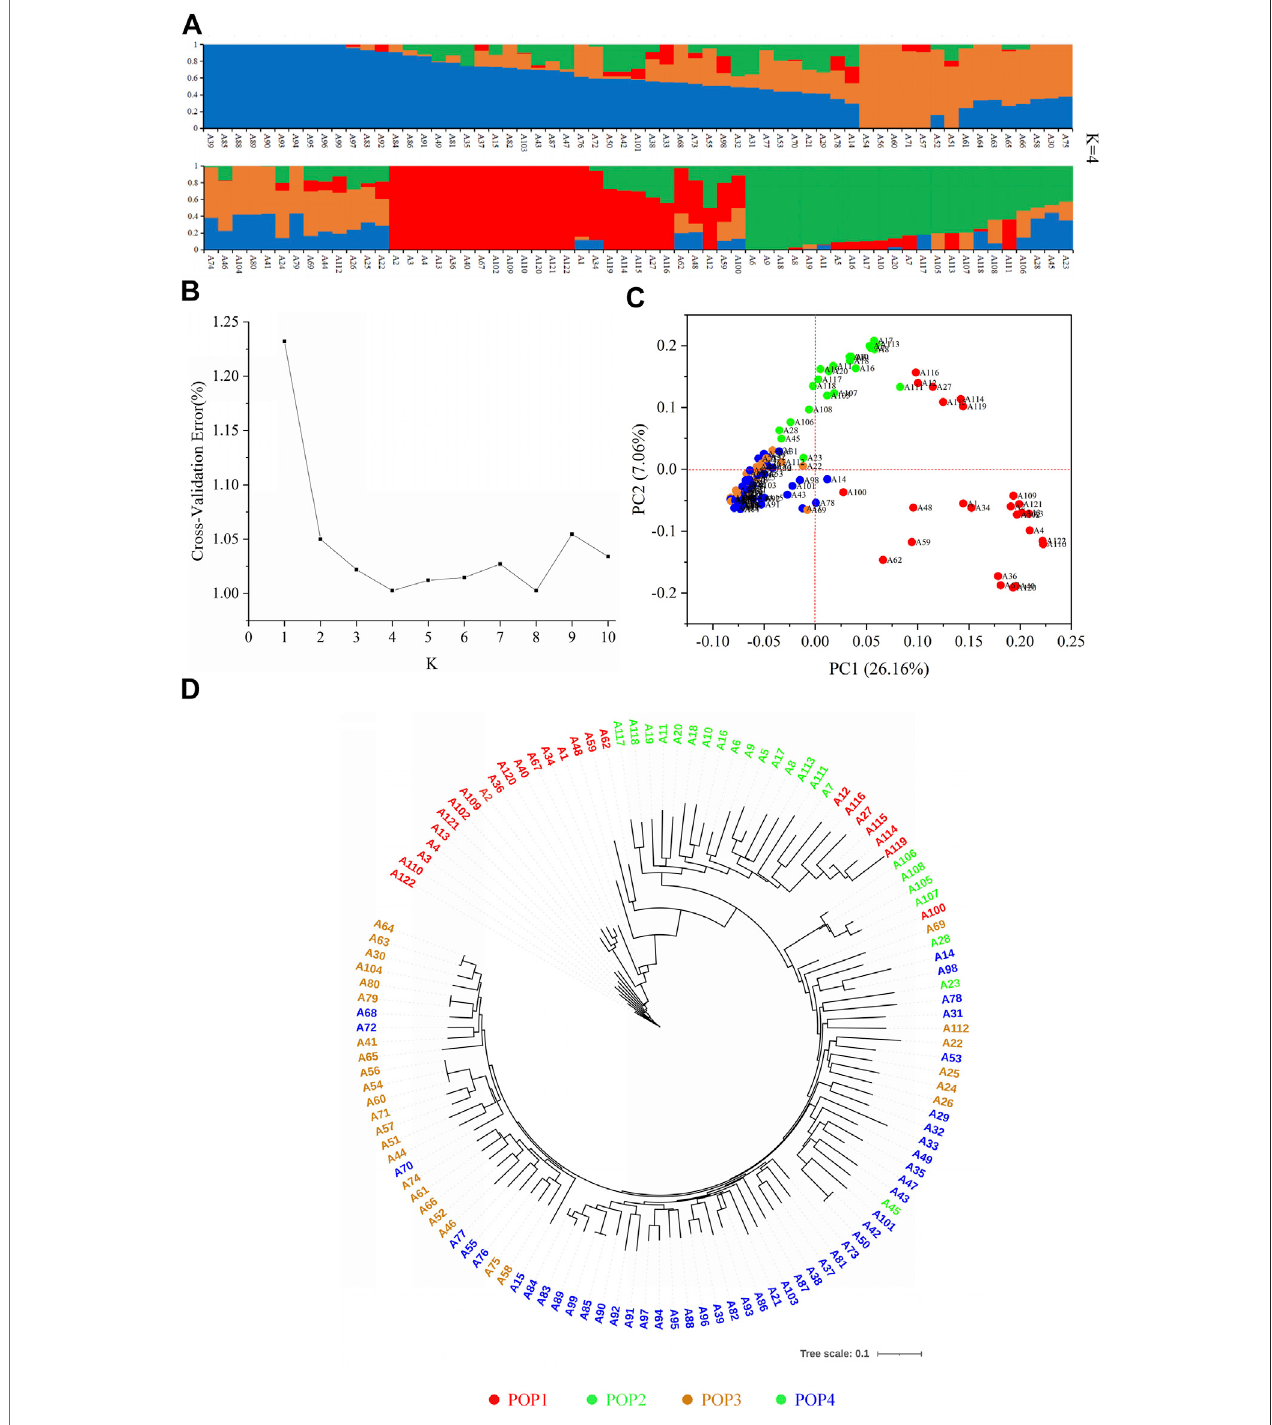
FIGURE3| Detailsofpopulationstructure analysisbyusing37,929SNPs basedon122ricegenotypes. (A) Populationstructures. (B) Cross-validationerrorvalue of different subgroups. (C) Principal component analysis. (D) Evolutionary tree diagram. Red, green, orange, and blue represent POP1, POP2, POP3, and POP4, respectively.